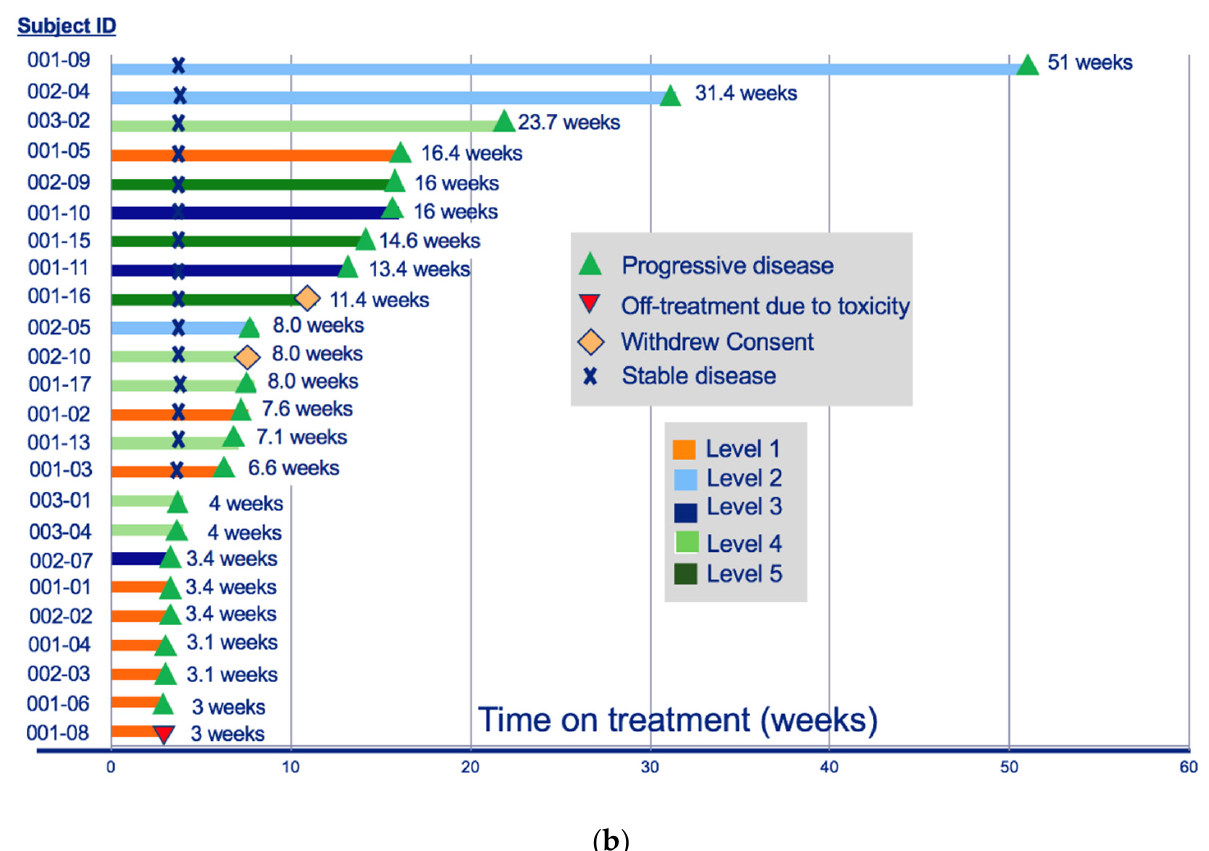
Figure 1. Clinical response to treatment: ( a ) best % change in sum of target lesions by investigator-assessed RECIST response, and ( b ) duration of treatment.